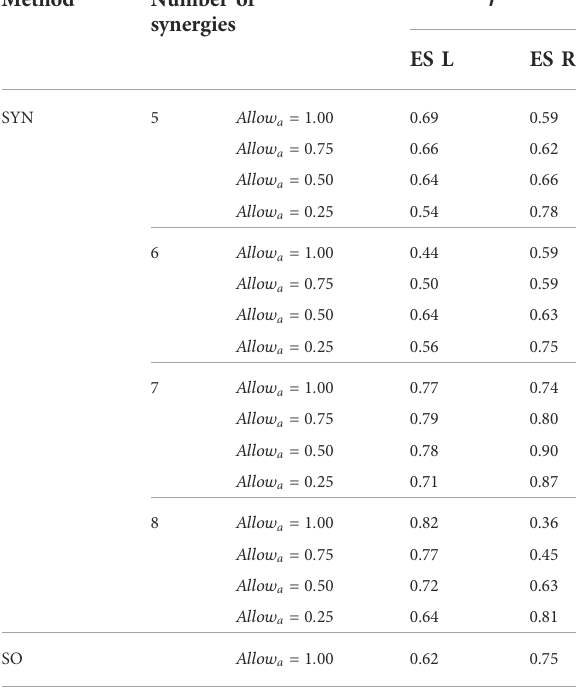
TABLE 3 The Pearson correlation coef fi cient, r , between the mean curves of the estimated activations and the measured muscle excitations of the erector spinae of the left side (ES L) and the right side (ES R) across the 10 gait cycles selected for analysis. Two estimationmethodswerecompared,theproposedsynergy-based approach (SYN) using 5 – 8 muscle synergies per side and static optimization (SO). Allow a indicated the allowable activation value used in the optimization formulation to minimize activation ( Optimization Formulation Section